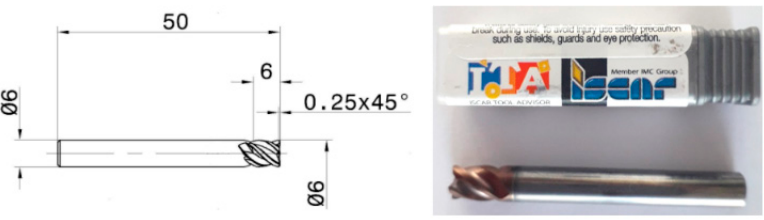
Figure 3. Type IC 608 endmill cutter used for performing the cutting tests, provided by